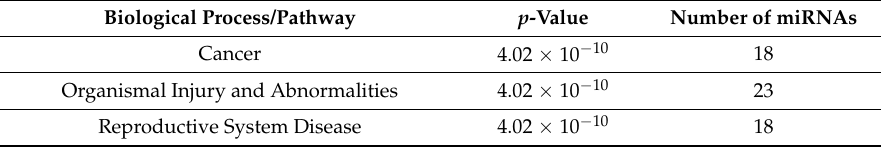
Table 5. Top biological functions regulated by significantly modulated